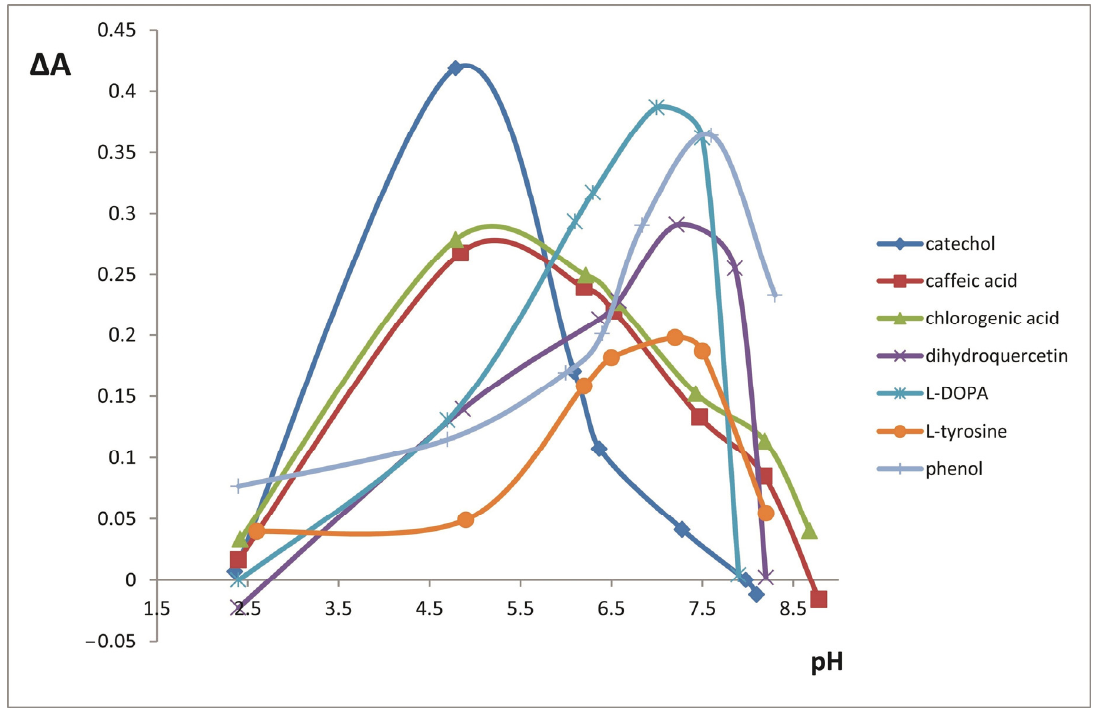
Figure 3. Influence of pH on the oxidation reaction speed ( ∆ A = A 270 s − A 30 s for catechol, ca ff eic acid, chlorogenic acid, dihydroquercetin, and l -DOPA; ∆ A = A 60 min − A 10 min for l -tyrosine and phenol). C(substrate) = 1.0 × 10 − 3 M, ABE activity = 265 U.